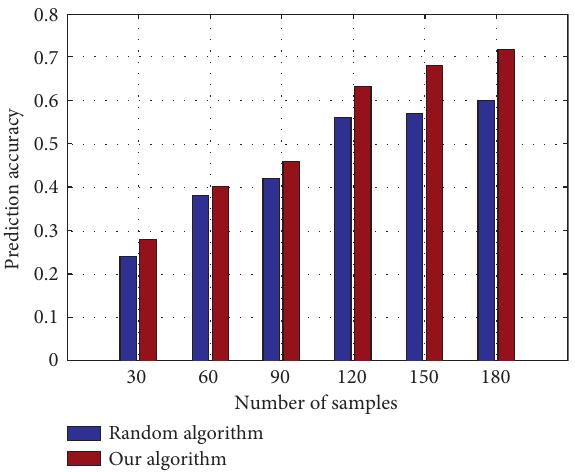
Figure 8: Comparison of computing resource